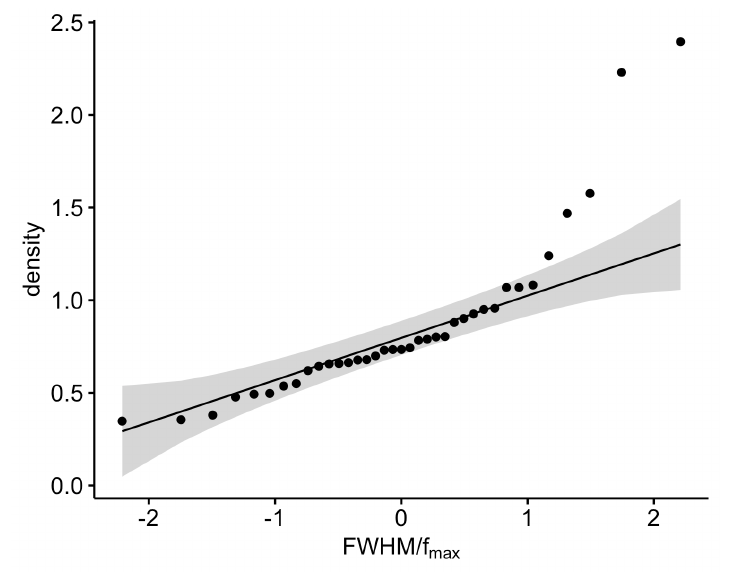
Figure 11. QQ nomality plot of FWHM / f max values of Table 3 for the raw time